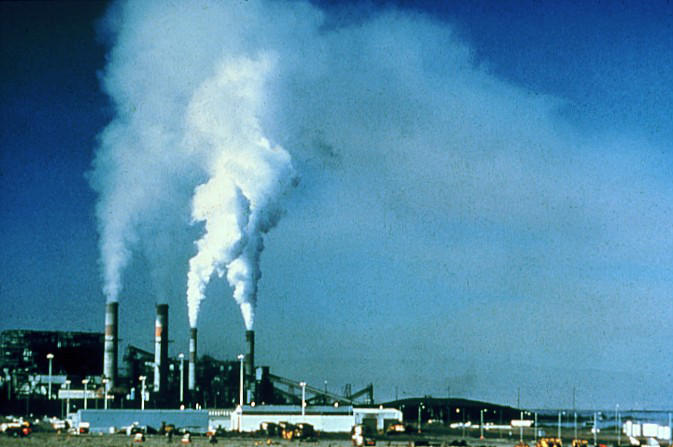
When mercury emitted from coal-fired power plants settles in wetlands or bodies of water, bacteria living in sediments transforms it into methylmercury—which is particularly toxic to the developing brain. (Photo: National Parks Service)